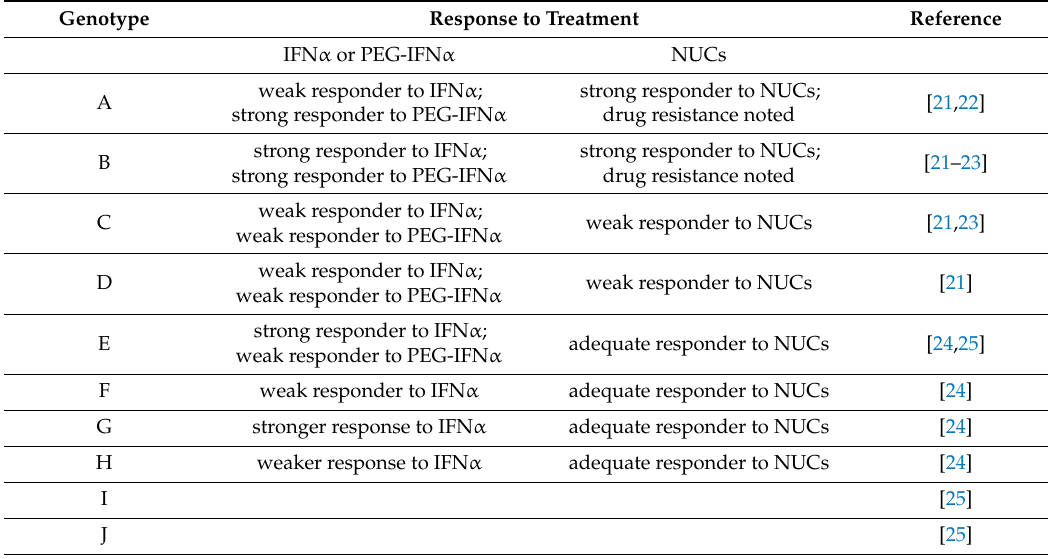
Table 2. Summary HBV genotype responses to CHB treatment by IFN α or PEG-IFN α and